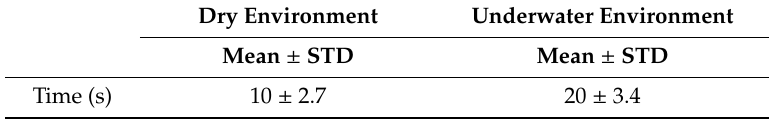
Table 1. Mean and standard deviation for the measurement duration in dry and underwater environments.